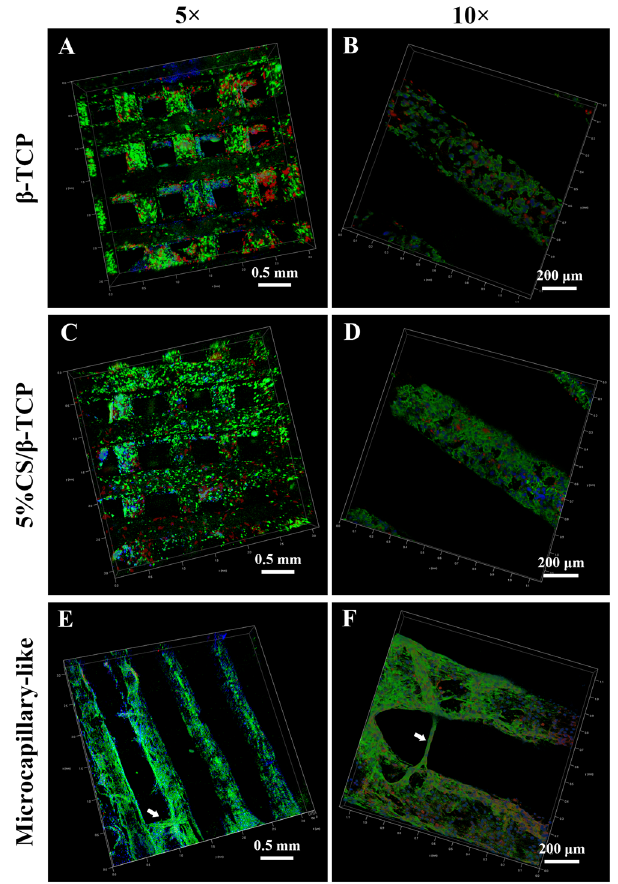
Figure 5. Confocal laser scanning microscopy of co-cultured cells on β -TCP and 5%CS/ β -TCP scaffolds. Confocal images of HUVECs co-cultured with hBMSCs on ( A , B ) β -TCP and ( C , D ) 5%CS/ β -TCP scaffolds for 3 days. Viable cells were stained with FITC (green), nuclei were stained with DAPI (blue), and hBMSCs were tracked with CM-Dil (red). ( E , F ) Confocal images of HUVECs co-cultured with hBMSCs labeled with CM-Dil (red) on 5%CS/ β -TCP scaffolds for 10 days. Endothelial cells were stained with CD31 (green), and nuclei were stained with DAPI (blue). White arrows mark CD31-positive microcapillary-like